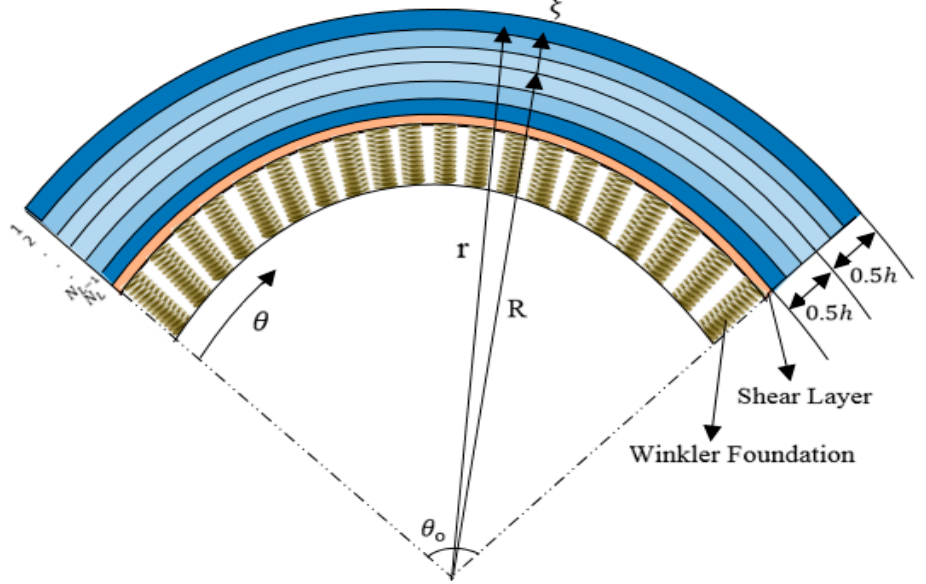
Figure 1. Mechanical model of a multi-layer graphene nanoplatelets (GPL) / polymer nanocomposite curved nanobeam.